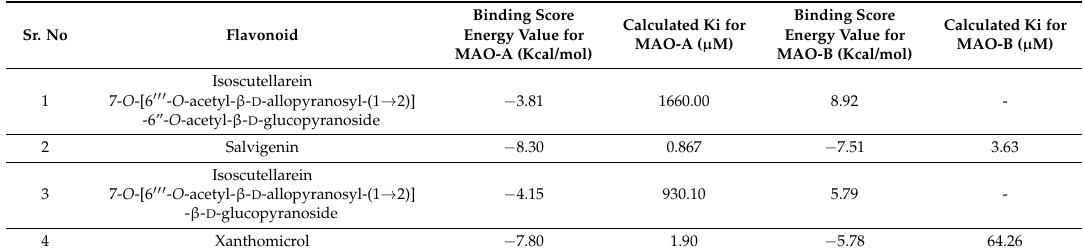
Table 2. Docking profile of natural flavonoids from Sideritis , against MAO-A PDB (2Z5X) and MAO-B PDB (2XFU) with docking score and free binding energy ( ∆ G) and Ki ( µ M). Sr. No Flavonoid